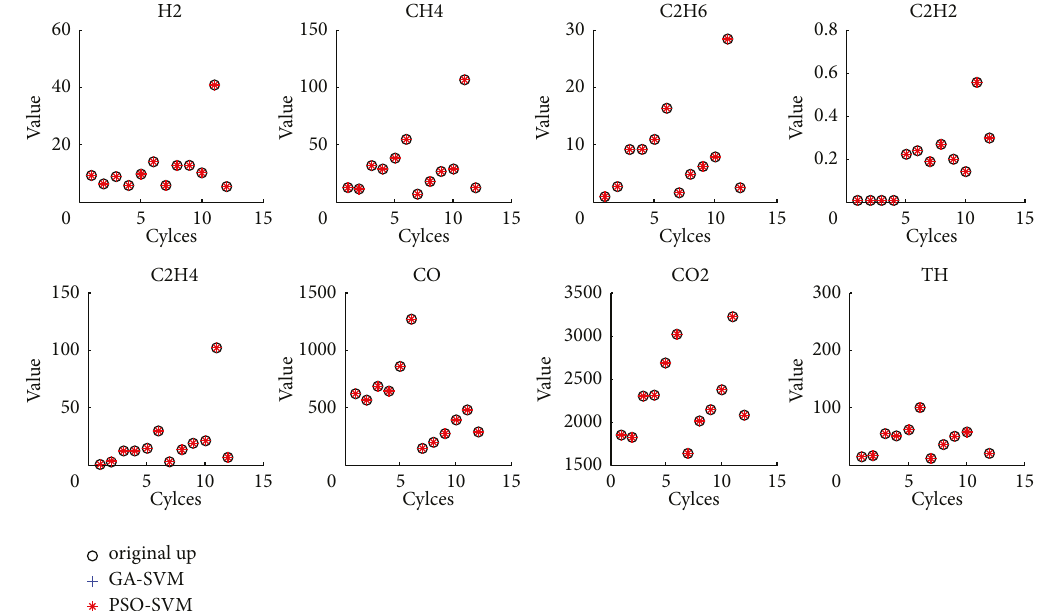
Figure 6: The predicted value of the GA-SVM/PSO-SVM regression model based on the high value obtained by the information granulation of DGA condition monitoring (set as Up) vs. Up.